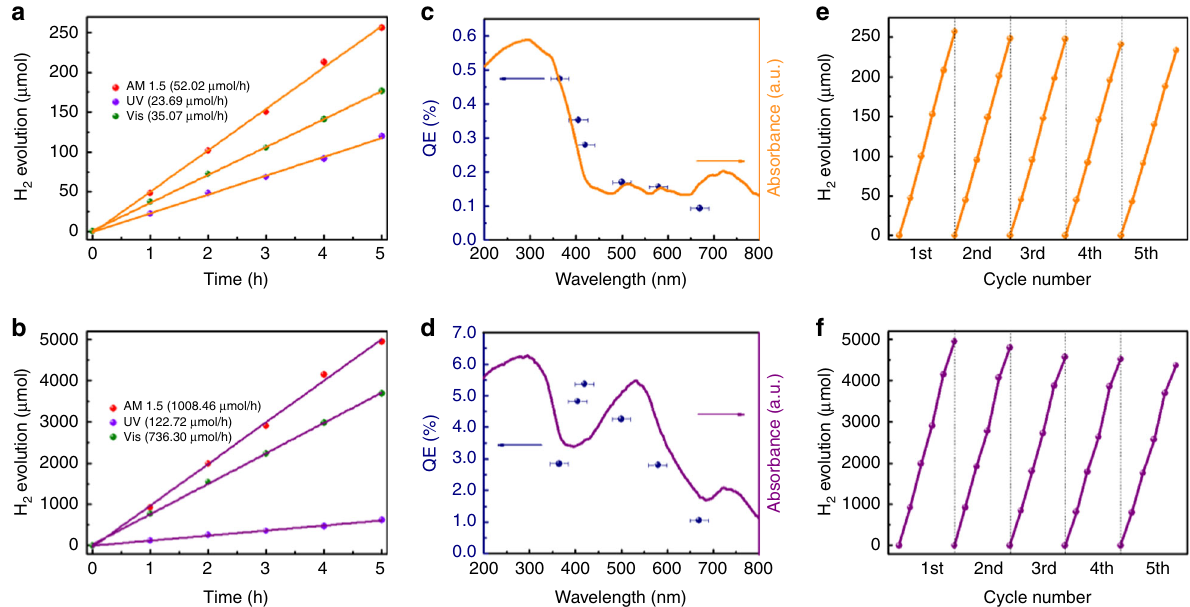
Fig. 3 Photocatalytic H 2 evolution activities evaluation. a , b Typical time courses of H 2 evolution upon AM 1.5, UV and Vis irradiations over 2DA ( a ) and 2DPA ( b ). c , d Wavelength-dependent QEs (blue dots) of 2DA ( c ) and 2DPA ( d ). The corresponding optical absorption spectra are superimposed for comparison. The error bars indicate the bandwidths of the fi lters used. e , f Cycling tests of photocatalytic H 2 evolution upon AM 1.5 irradiation over